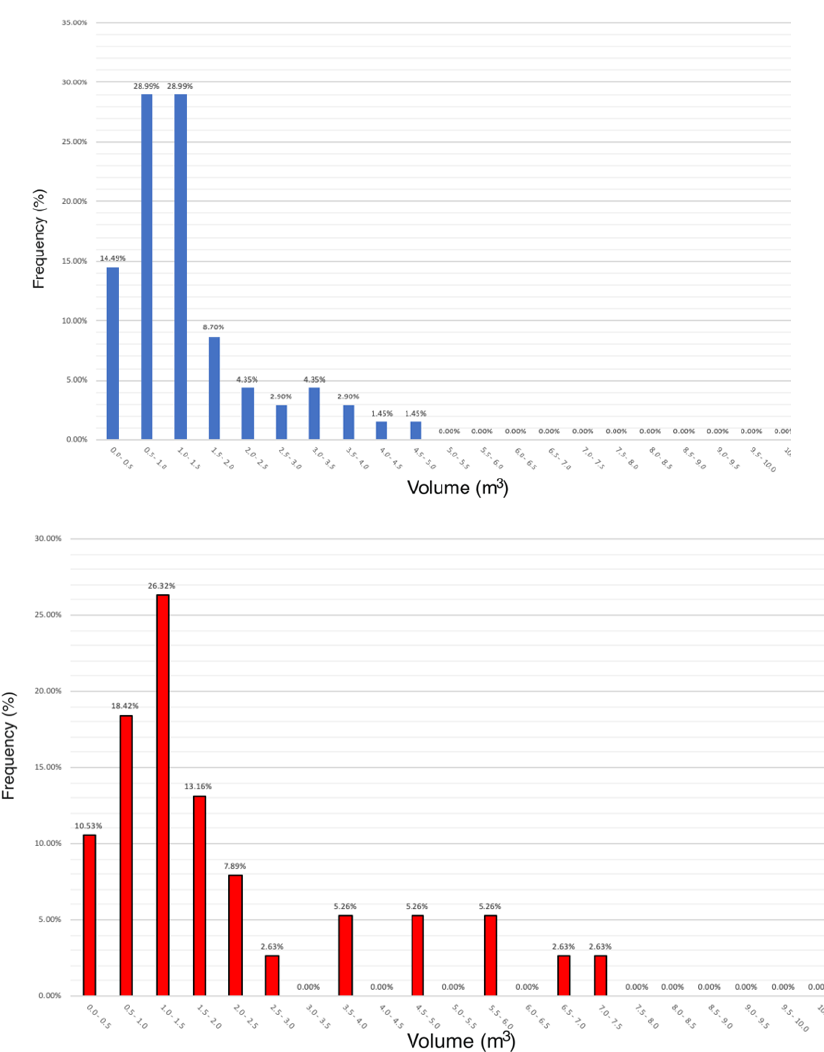
Figure 16. Volume distribution for both the fallen (blue) and the potentially unstable (red) blocks for sub-region U2.